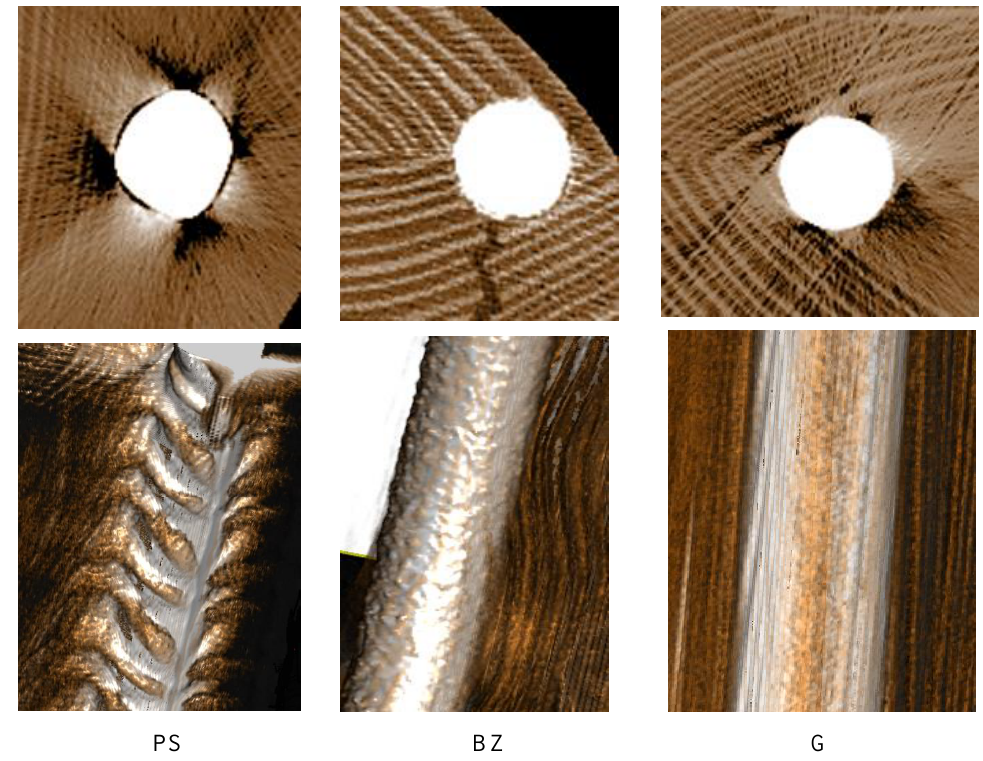
Figure 12. CT scans (1:1 scale). Upper image line—crosswise view, lower image line—longitudinal view.